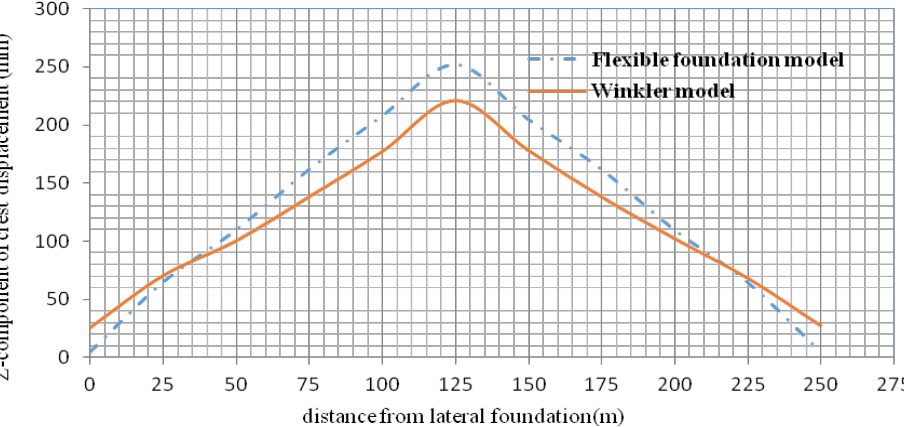
Fig. 3. The value of dam crest displacement in depth (z-direction) in arc dam crest (mm) against distance from lateral foundation